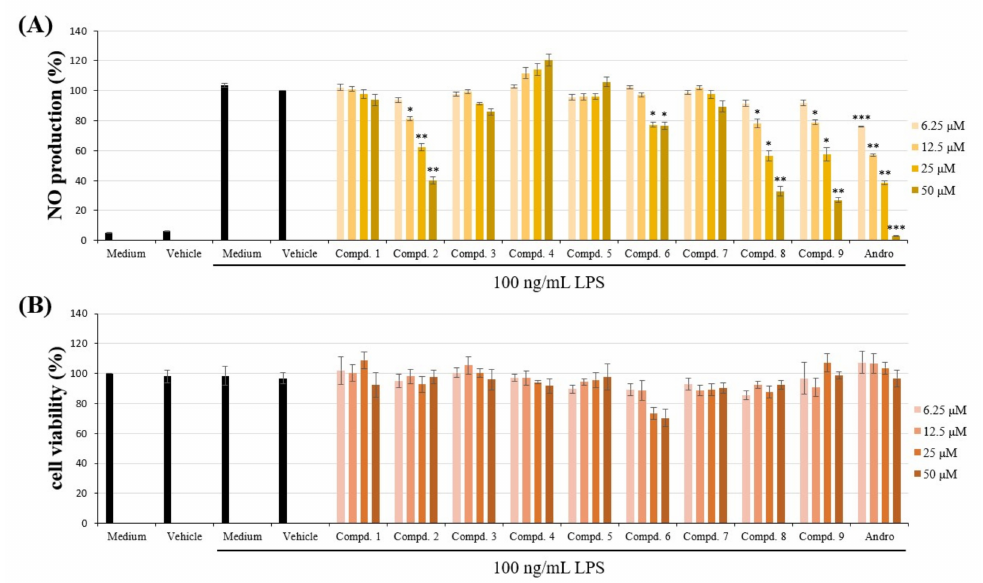
Figure 8. E ff ects of Compound 1 – 9 from Hypericum sampsonii on ( A ) NO production and ( B ) cytotoxicity in LPS-induced RAW264.7 macrophages. Data expressed as means ± SEM (n = 3). Asterisks indicate significant di ff erences (* p < 0.05, ** p < 0.01 and *** p < 0.001) from the (media + DMSO + LPS) control